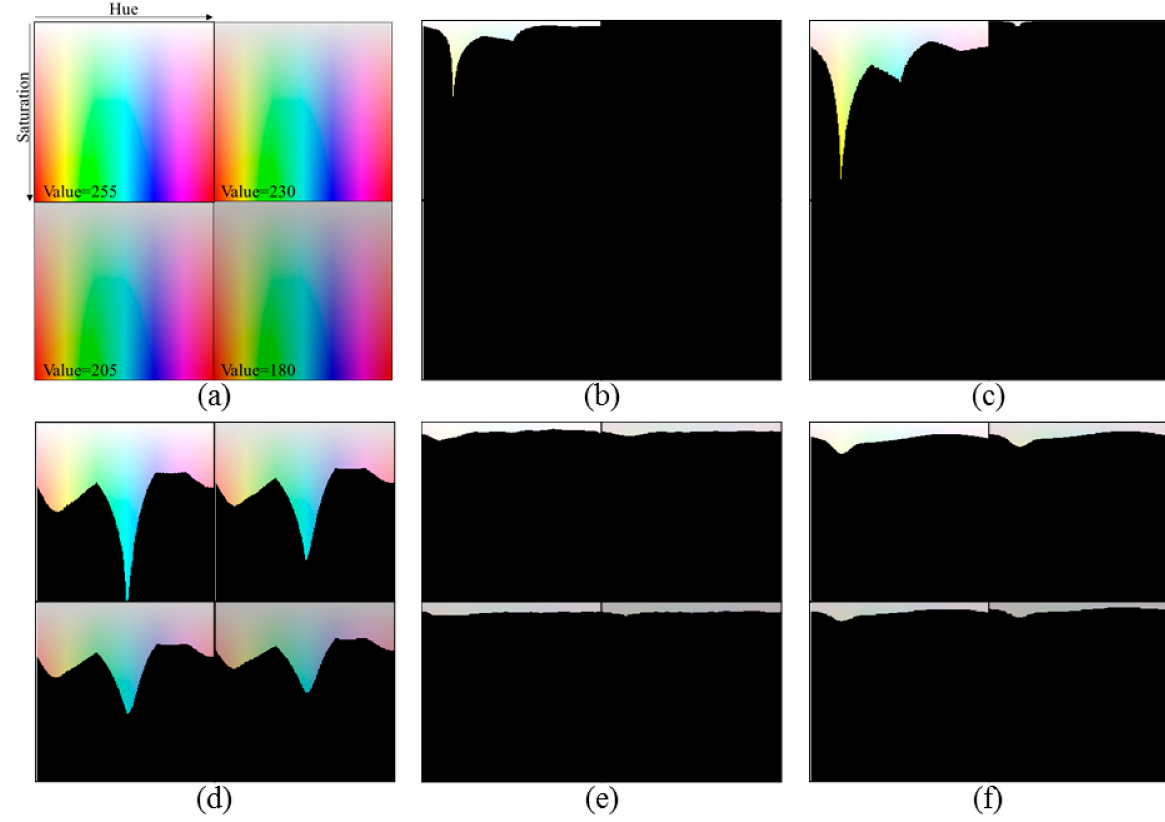
Figure 1. Comparison of the OER detection results. ( a ) Original test image; ( b ) OER detected using the brightness thresholding method (L* > 98) [8]; ( c ) OER detected using the brightness thresholding method (Y ≥ 230) [9]; ( d ) OER detected using the over-exposed map based thresholding method [10]; ( e ) Perceived OER identified through a subjective evaluation; ( f ) OER detected using the proposed